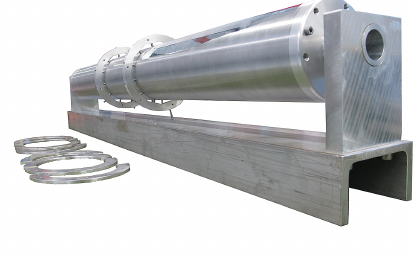
Figure 5. Mandrel for the fabrication of the inner carbon fiber